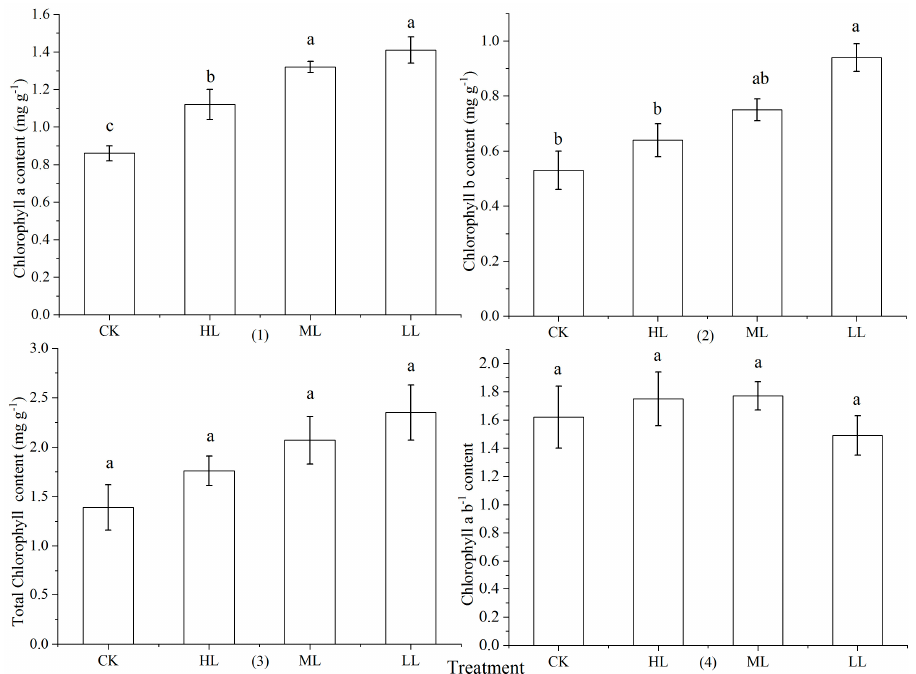
Figure 2. The chlorophyll a content ( 1 ), chlorophyll b content ( 2 ), total chlorophyll content ( 3 ), and